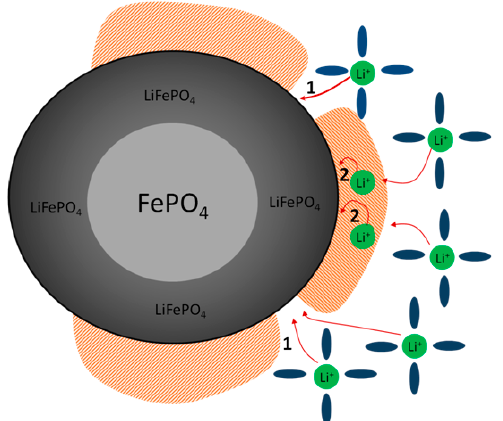
Figure 11. Diagram of ionic transport in an electrode material using a PEDOT:PSS / CMC binder. 1, ionic transport in polymer pores; 2, ionic transport in the polymer.